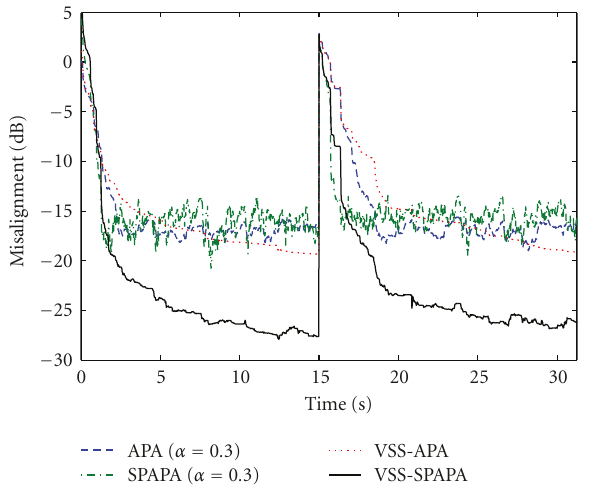
Figure 5: Comparison of tracking ability of the relevant algorithms with speech signals, P = 4. The unknown impulse response changes after 15 seconds.